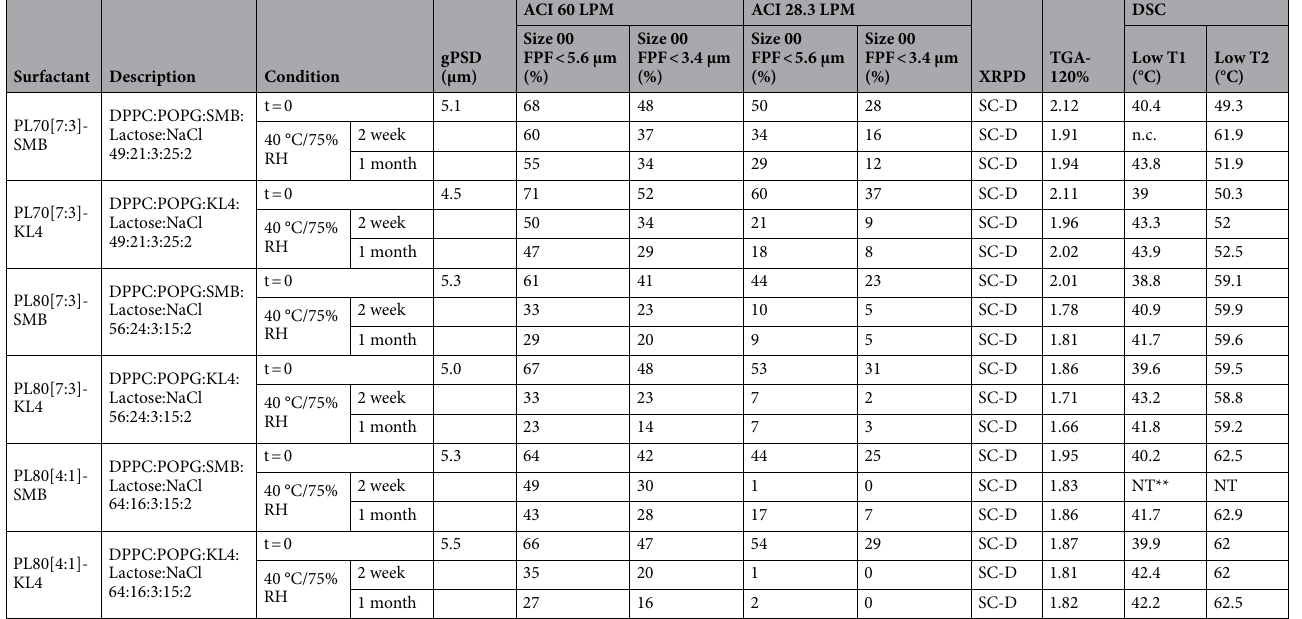
Table 2. Aerosol properties and solid state properties of each of the first series of dry powder surfactant formulations tested. Powders vary according to phospholipid ratio (DPPC:POPG 7:3 or 4:1) and quantity (70 or 80 wt%) and SP-B peptide mimic (SMB or KL4), but all contain lactose as excipient. *RH: Relative Humidity; **NT: not tested; n.c.: not calculated.